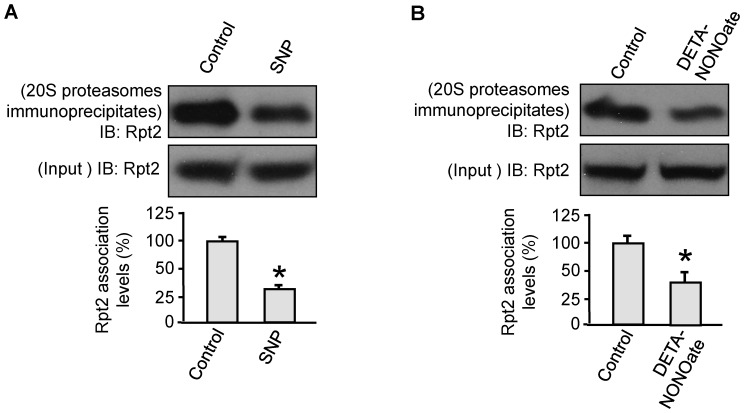
SNP reduces the association of 19S proteasome subcomplex with the 20S subcomplex.The HUVEC were incubated with (A) SNP (50 µM) for 0.5 h or (B) DETA-NONOate (10 µM) for 0.5 h followed by isolation of intact 26S proteasomes which were then subjected to immunoprecipitation using agarose immobilized with antibody recognizing the 20S proteasome subcomplex (Enzo Life Sciences, Farmingdale, NY; Cat# BML-PW1075). Rpt2 was detected via Western blotting on the immunoprecipitates of 20S proteasome subcomplex. Purification of intact 26S proteasomes was conducted according to the instruction of the manufacture (UBPBio, Aurora, CO; Rapid 26S Proteasome Purification Kit; Cat# J4320). p<0.05 vs control (n = 3). Ctrl, control; SNP, sodium nitroprusside.